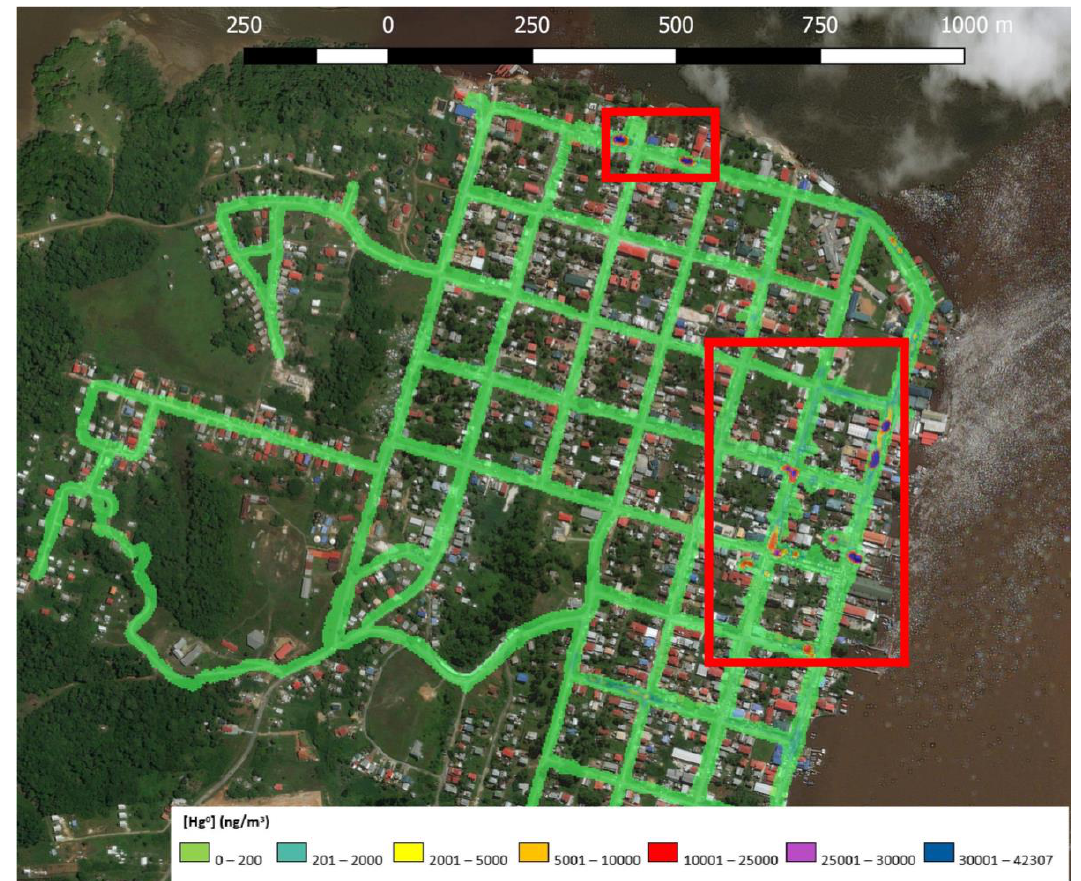
Figure 3. Map of Central Bartica, consisting of maximum Hg 0 concentrations found during Bartica training, May 2019. The majority of active gold shops were located within the red